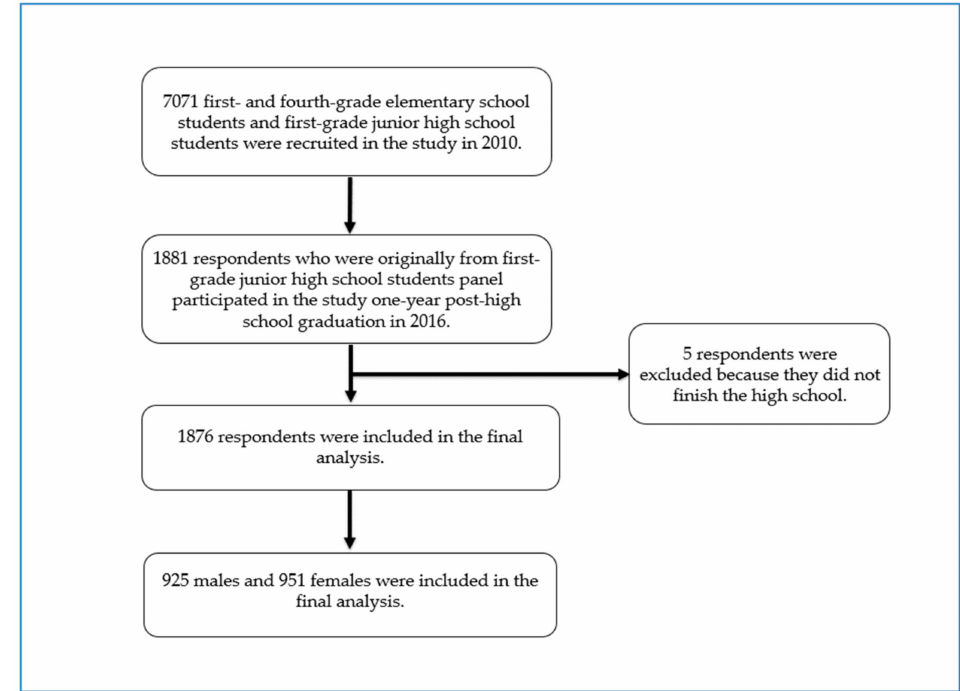
Figure 1. Selection process of study